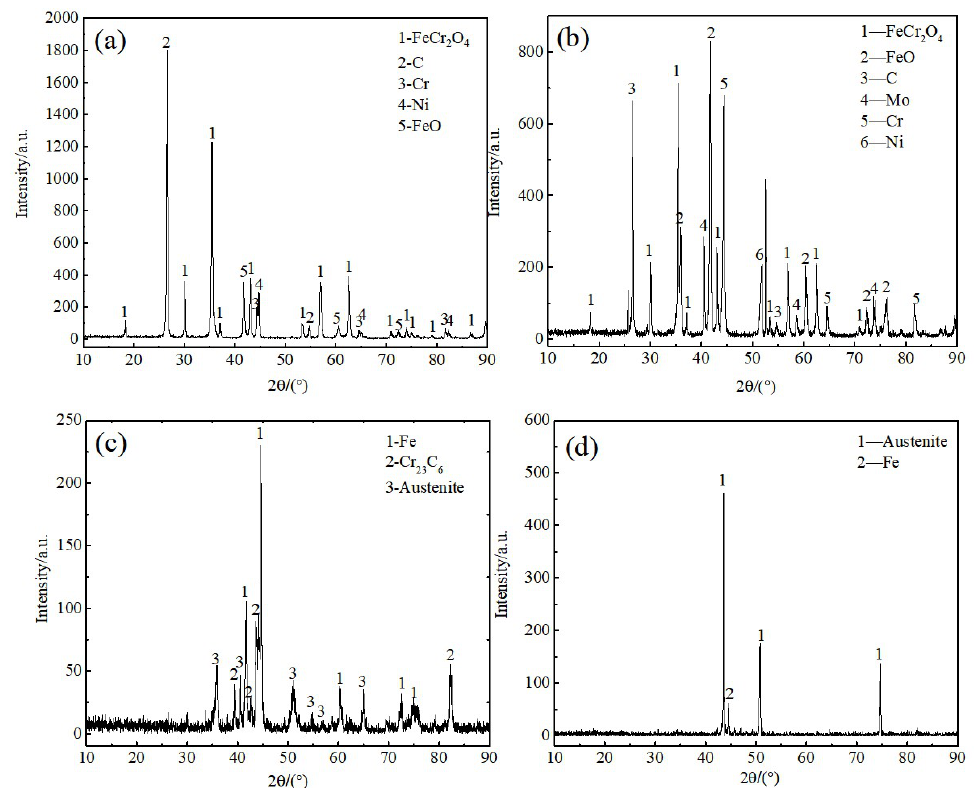
Figure 12. XRD pattern of sintering sample at 10 −4 atm and different temperatures for 180 min; ( a ) 700 °C; ( b ) 900 °C; ( c ) 1100 °C; and ( d ) 1200 °C.